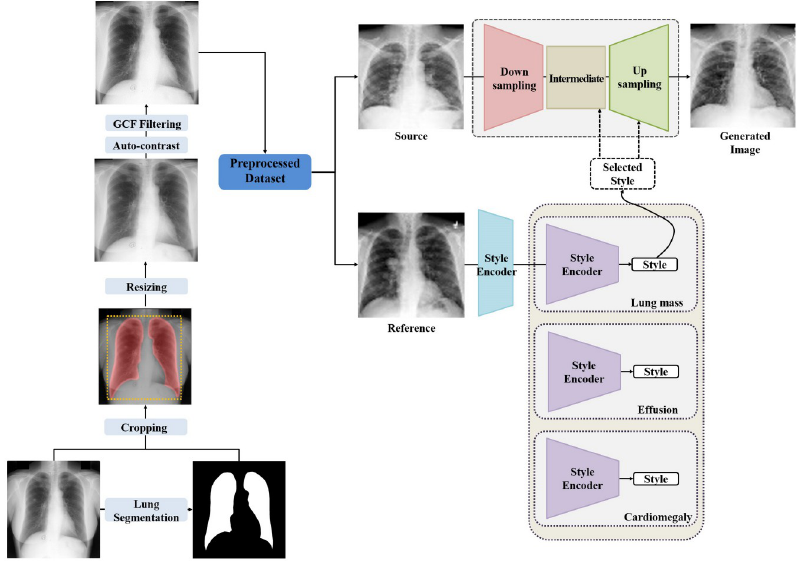
Fig 1. Chest radiography synthesis